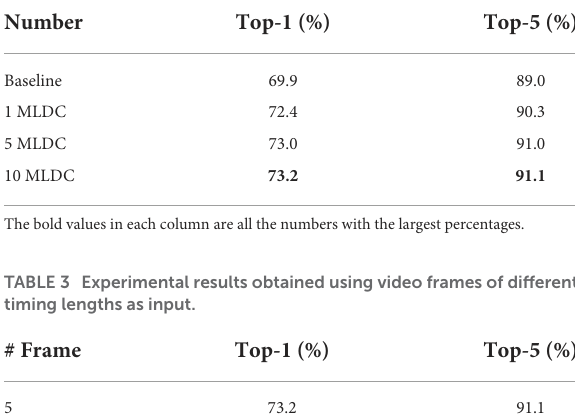
TABLE 1 Experimental results of embedding MLDC modules at different locations of ResNet network.